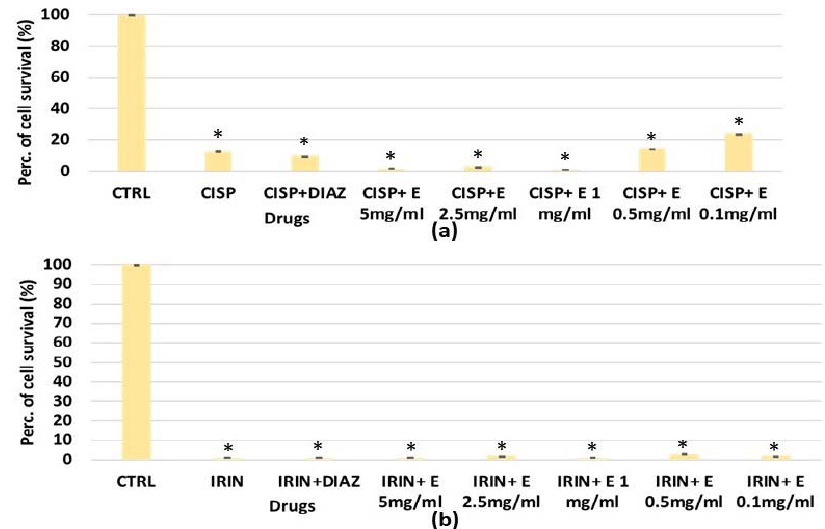
Figure 10. Percentage of cell growth values for SHSY5Y cells co ‐ incubated after 72 h ( a ) with cispla ‐ tin (CISP) 1 × 10 − 4 M, ( b ) irinotecan (IRIN) 1 × 10 − 4 M and diazoxide 2.5 × 10 − 6 M (DIAZ) or different concentrations of the extract (E) measured via MTT assay. The reported values represent a mean of at least four replicates. One ‐ way analysis of variance with ANOVA was performed to determine the significance of the data with a value of p < 0.05 *.